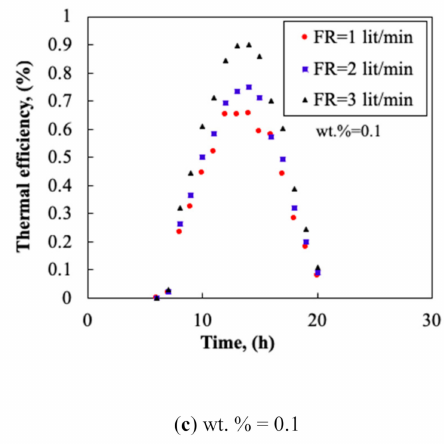
Figure 13. Dependence of thermal e ffi ciency of collector on time for various mass fractions of CNPs in